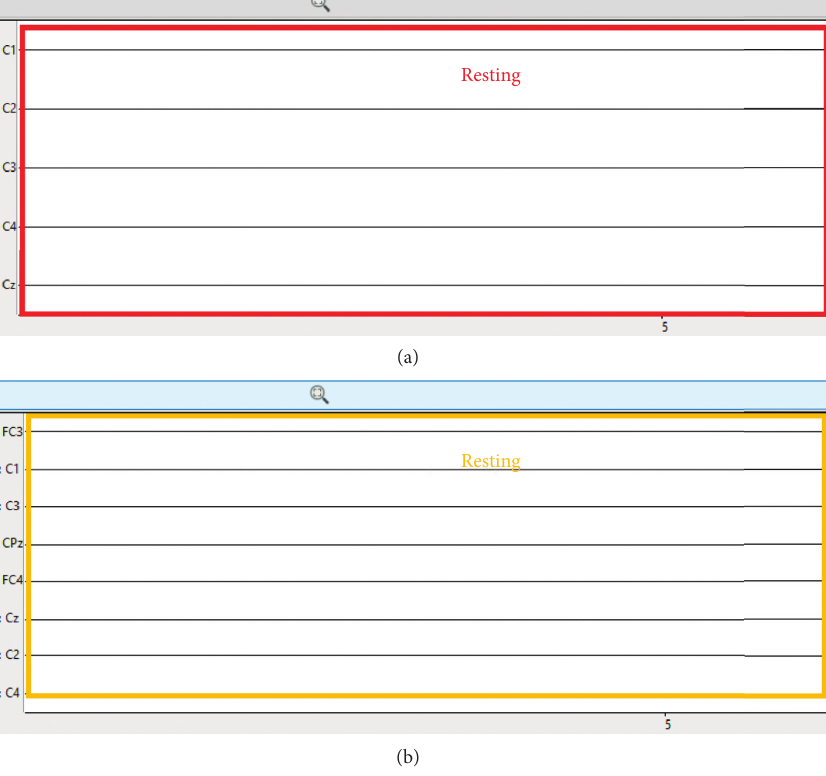
Figure 10: The behavior of the mu and beta rhythms at resting state.